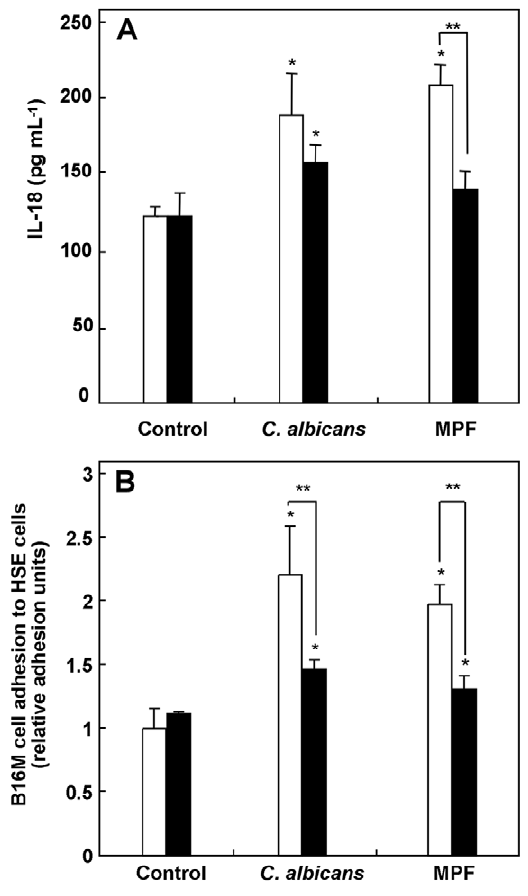
Figure 5. Effect of the mannose receptor ( MR ) inhibition. Effect of the anti-mannose receptor antibodies (anti-MR) on the inhibition of the synthesis of IL-18 (A) and tumor cell adhesion to hepatic sinusoidal endothelial (HSE) cells (B) induced by Candida albicans UPV1413 and its mannoprotein-enriched fraction (MPF): basal medium ( % ), 30 m g/ml anti-MR ( & ). The results shown correspond to the mean 6 SD of three independent experiments. Statistically significant differences with respect to the controls or to the cells without antibodies are indicated by one (*) and two asterisks (**) (p , 0.05), respectively.